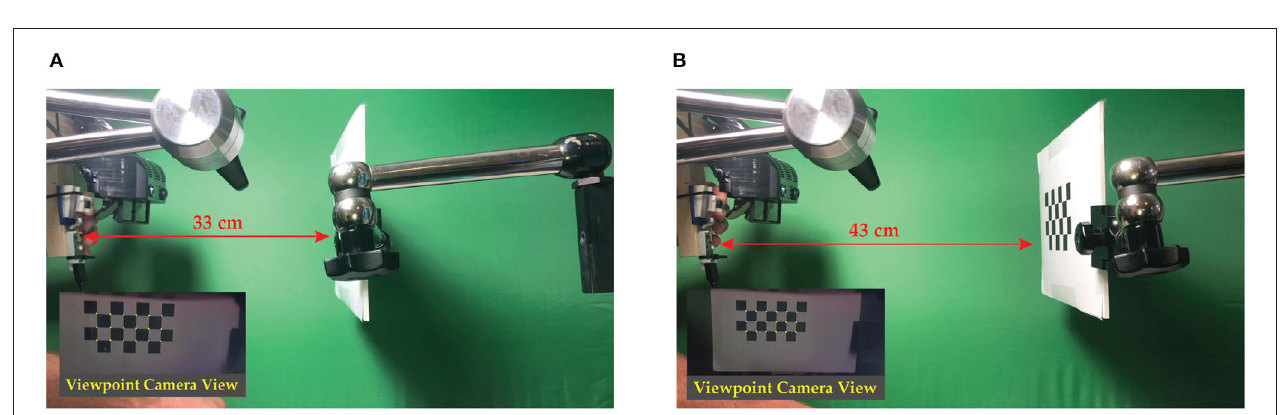
FIGURE 9 | Images grabbed during two different testing sessions: in (A) the validation checkerboard is placed at 33 cm from the viewpoint camera, whereas in (B) the validation checkerboard is placed at 43 cm from the viewpoint camera. Bottom-left detail shows the viewpoint camera view of the augmented scene. TABLE 2 | Registration error measured at different viewpoint-to-checkerboard distances for the calibration position. Mean Checkerboard distances